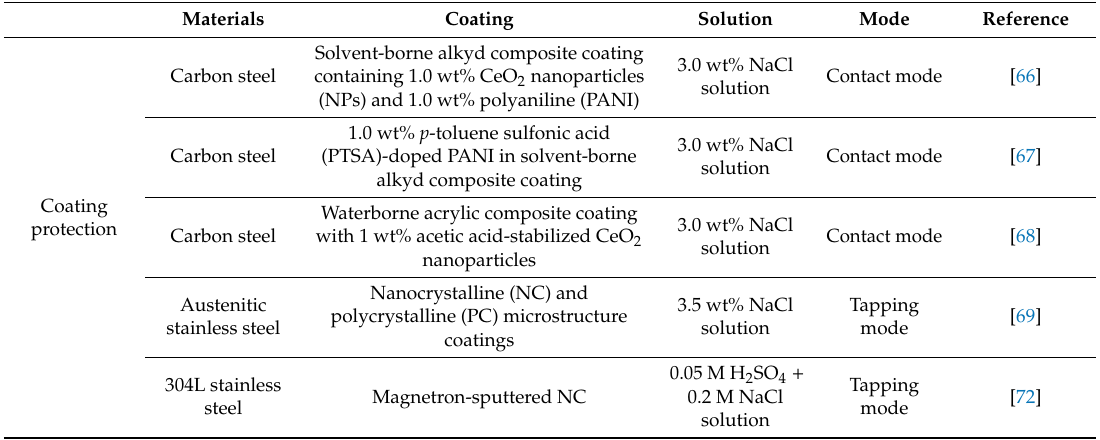
Table 6. Summary of the application of EC-AFM in coating